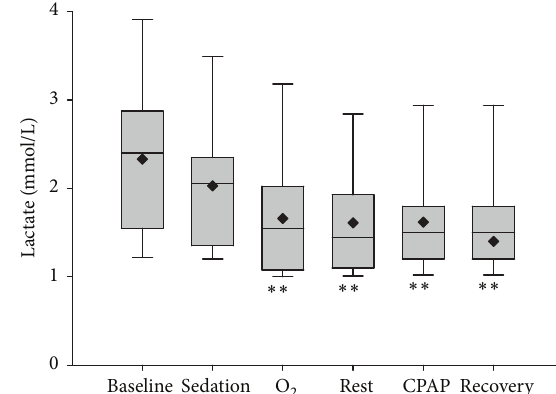
Figure 5: Arterial blood lactate concentration following respira- tory support by oxygen insufflation or continuous positive airway pressure (CPAP). Values are shown as median (horizontal line) and mean (diamond) and quartiles and range immediately after catheter placement (T0, baseline), 10 minutes following sedation (T1, sedation), following 10 minutes of oxygen supplementation (O 2 ), following 10 minutes of CPAP, and after 10 minutes of breathing ambient air following respiratory support (T3, rest, and T5, recovery). A significant time effect was observed, as results obtained after sedation were significantly less than baseline ( ∗∗ 𝑃 < 0.001 ). Order of respiratory support (O 2 supplementation or CPAP) was randomly assigned and had no significant effect on response to O 2 supplementation or